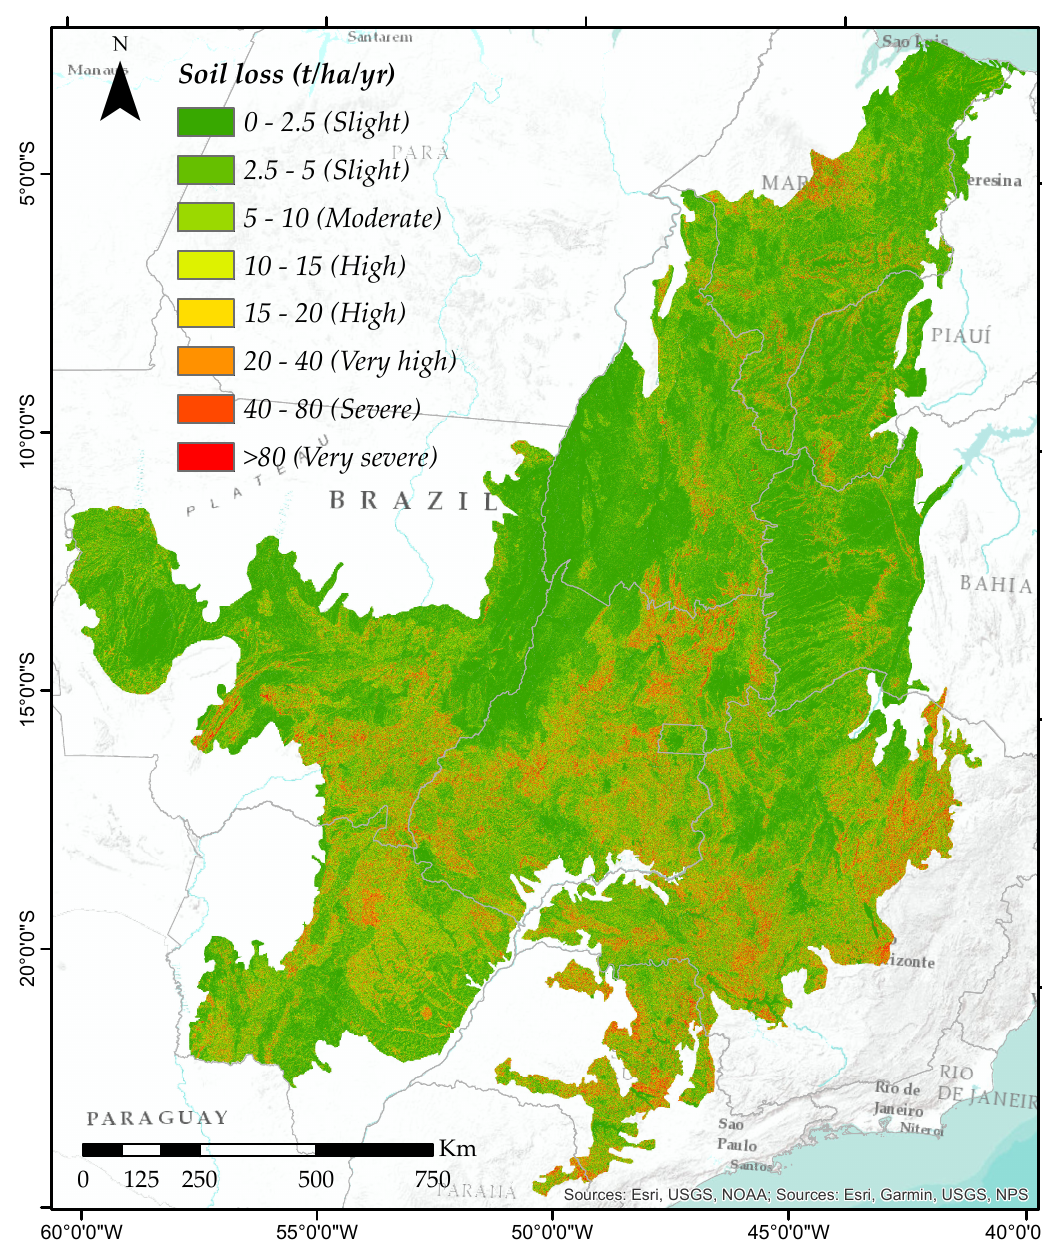
Figure 3. Map of potential soil loss rate (t ha − 1 yr − 1 ) in the Brazilian Cerrado (reference year: 2012). Table 6. Simulated potential soil loss (t ha − 1 yr − 1 ) for the agricultural land use of the Brazilian Cerrado for the years 2000 and